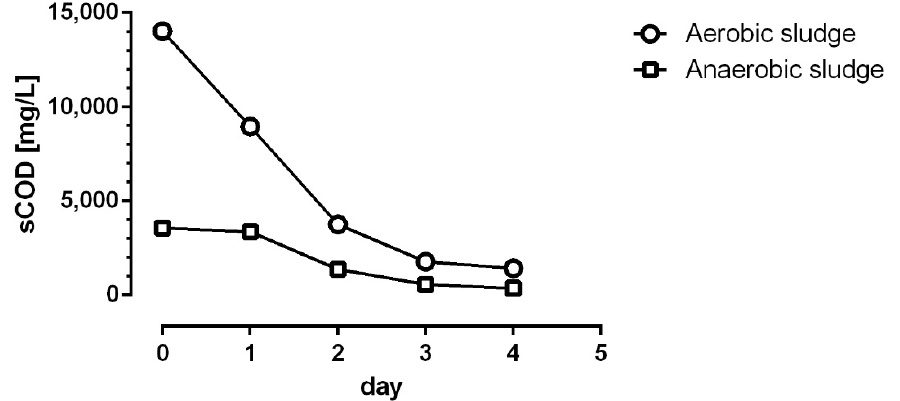
Figure 4. The concentration of sCOD during the preincubation process.